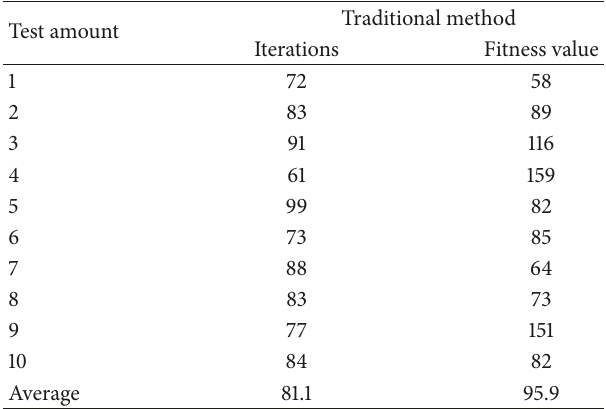
Table5:Numberofiterationsandfitnessofoutlierdatafeature-state responses detected with the traditional method.